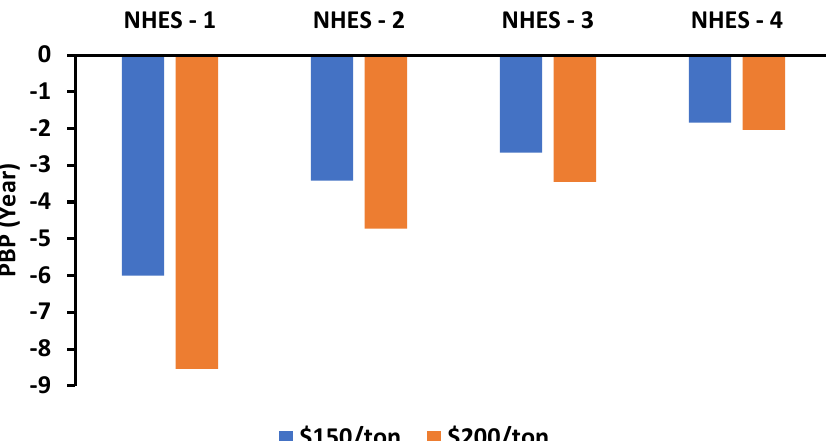
Figure 23. Difference in PBP based on increased carbon tax for New England region .